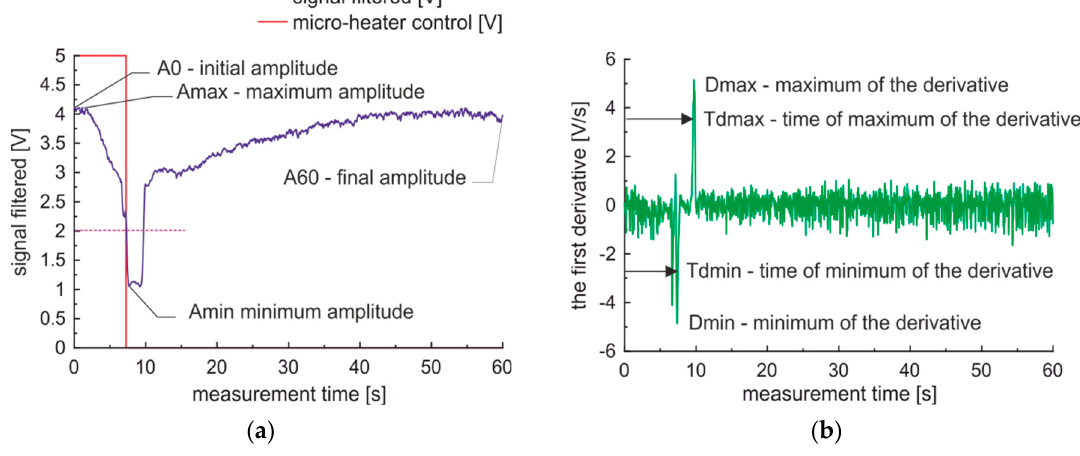
Figure 13. Data used to generate input vectors for fuel classification: ( a ) Signal; ( b ) The first derivative. Table 2. Input vector processing for artificial neural networks classifier.